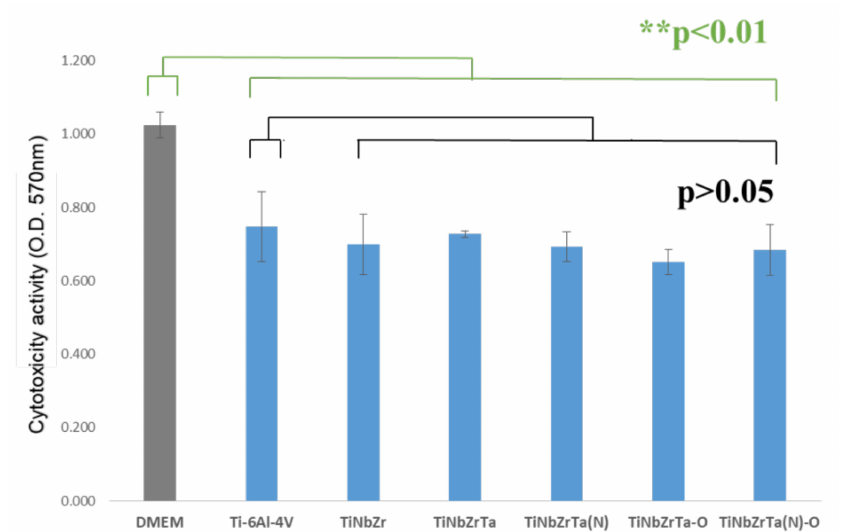
Figure 4. Cytotoxicity analysis of L-929 cultured on uncoated Ti-6Al-4V and TiNbZrTa series films for 48 h. DMEM acted as the medium with added serum and antibiotics without any coating